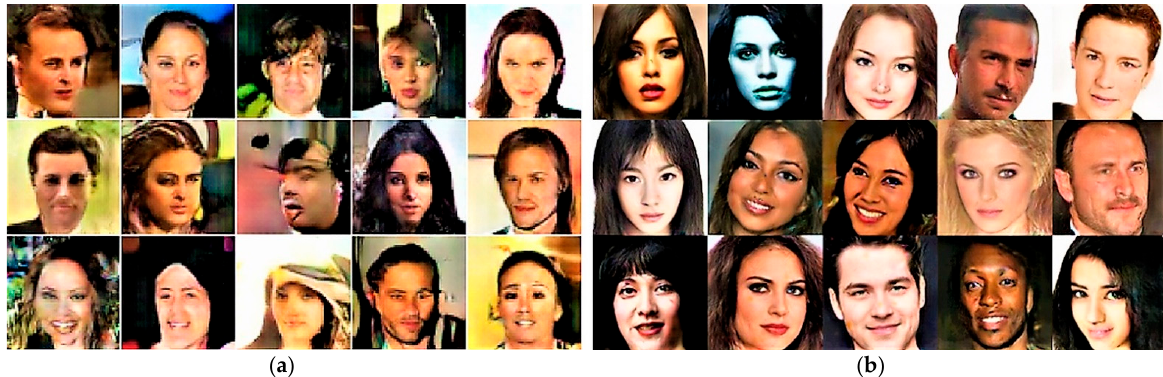
Figure 15. Faces generated by: ( a ) EBGAN; and ( b ) BEGAN. Table 8. The inception scores of various GANs, compared to real data. Method (Unsupervised) Score Real Data 11.24 BEGAN 5.62 ALI 5.34 MIX + WGAN 4.04